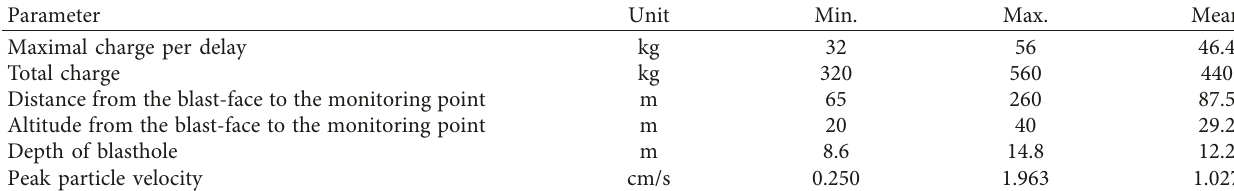
Table 4: Statistics for monitoring data.